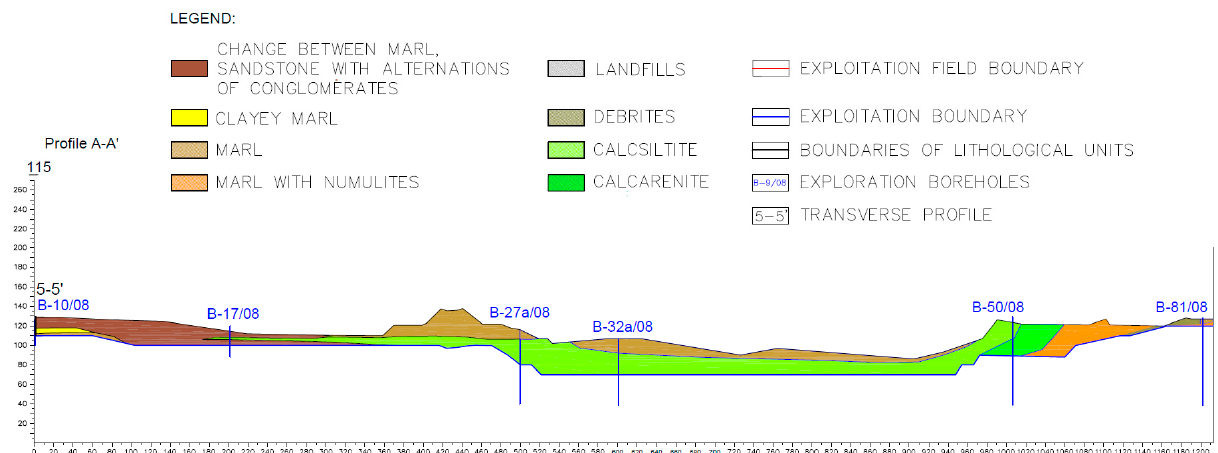
Figure 6. Longitudinal geological cross-section A–A’.